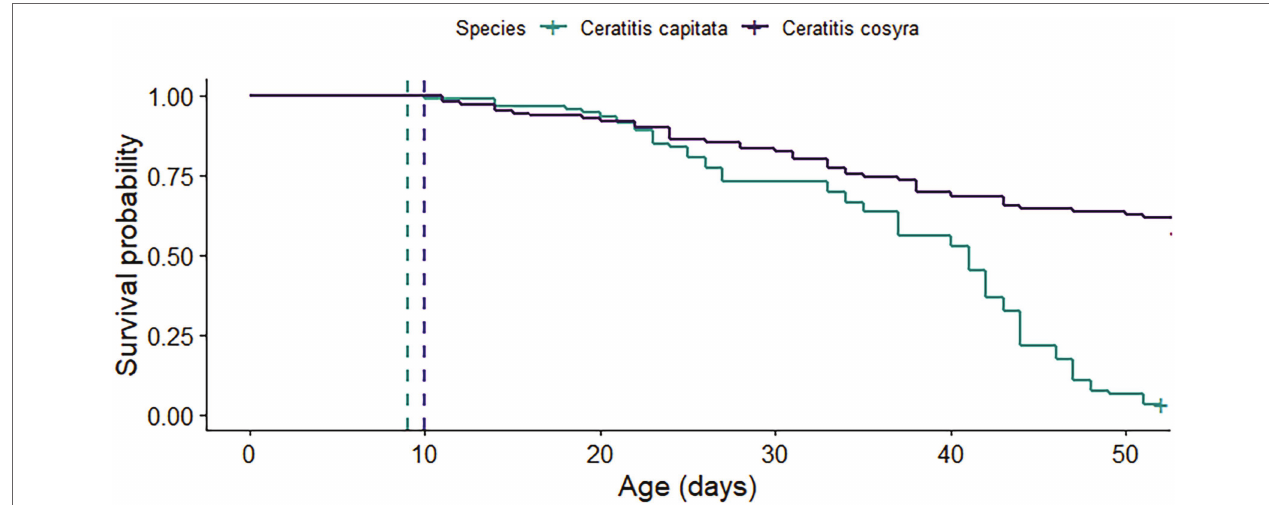
FIGURE 2 | Survival curves of C. capitata and C. cosyra females that were mated at 9 (blue dashed line) and 10 days old (purple dashed line) respectively. The curves represent 114 mated C. capitata and 140 mated C. cosyra that were kept in individual containers and were provided with fresh oviposition substrates each week. Survival of both species was recorded until 50 days